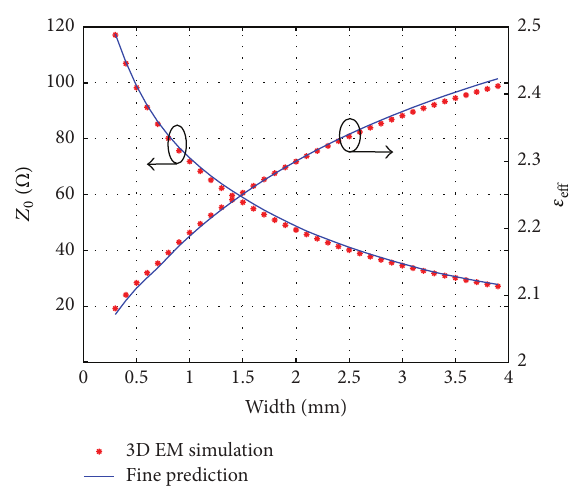
Figure 5: Comparative variations of characteristic impedance and effective dielectric constant versus width of the fine model and the 3D EM simulation on the substrate 𝜀 𝑟 = 2.94 , ℎ = 0.762 mm at 𝑓 = 6